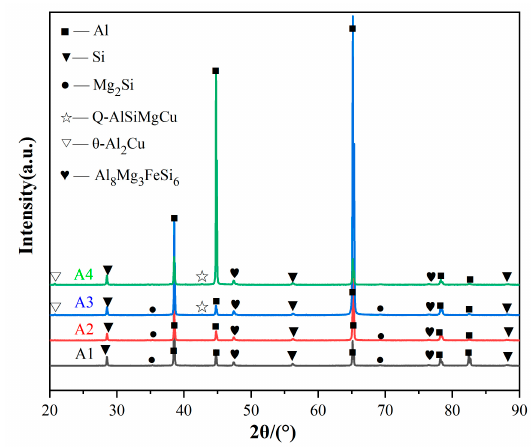
Figure 3. XRD image of as-cast alloys.